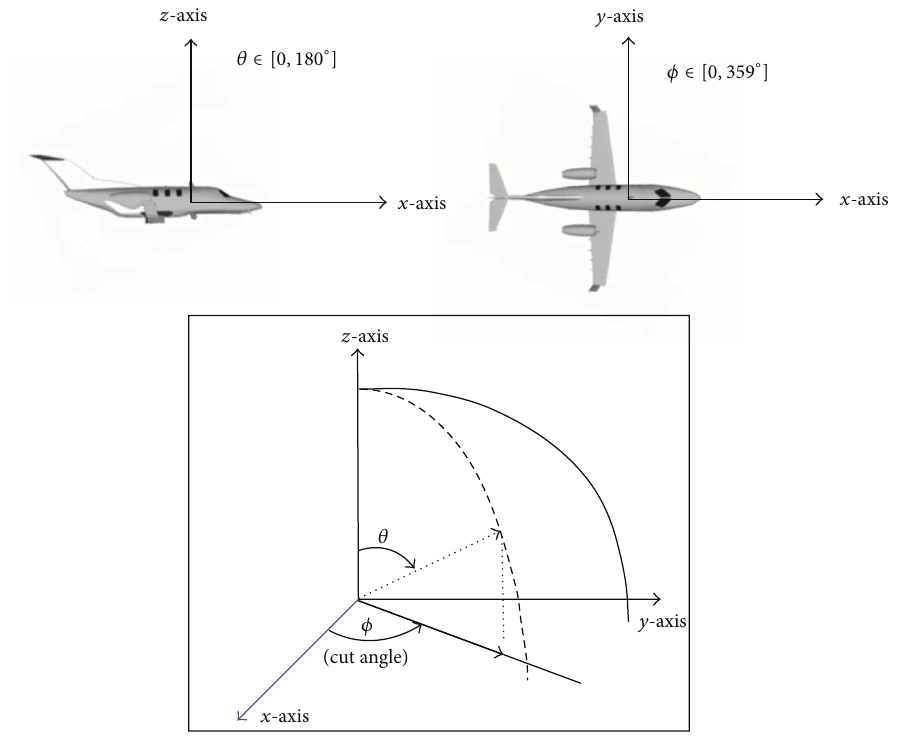
Figure 2: Antenna pattern angle definitions.